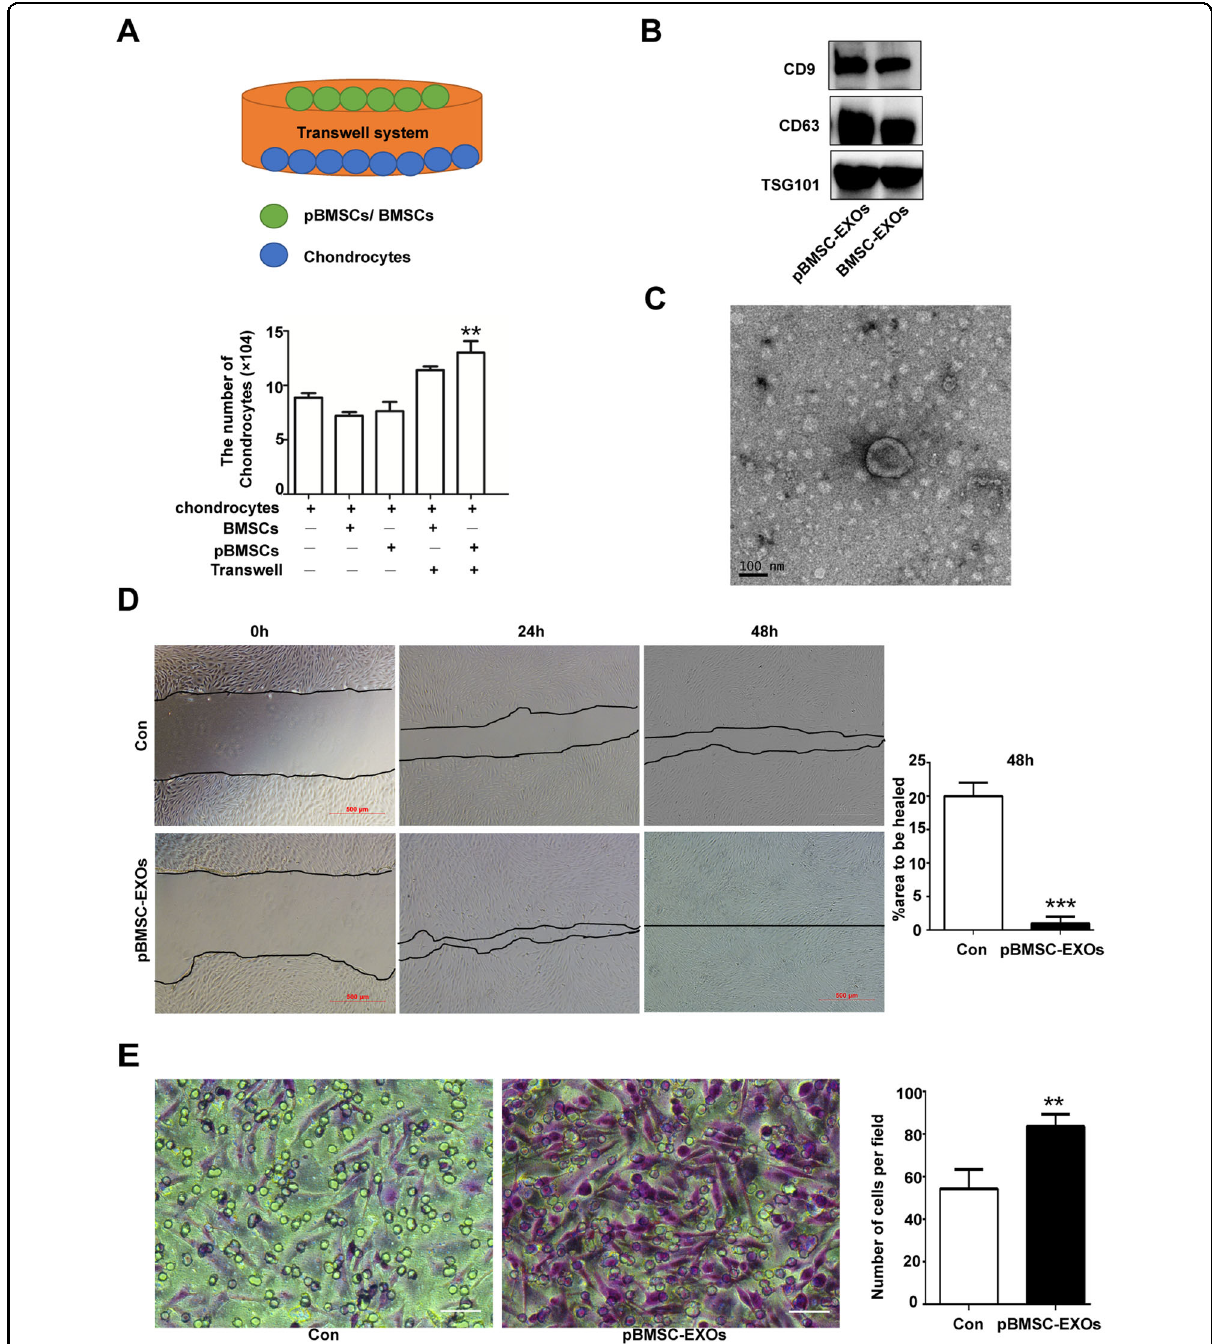
Fig. 4 Effects of the pBMSC-EXOs on the migration and proliferation of chondrocytes. A The proliferation of chondrocytes in coculture with pBMSCs and BMSCs. B Western blot analysis of the exosome-speci fi c CD9, CD63, and TSG101 proteins. C Morphology of the exosomes